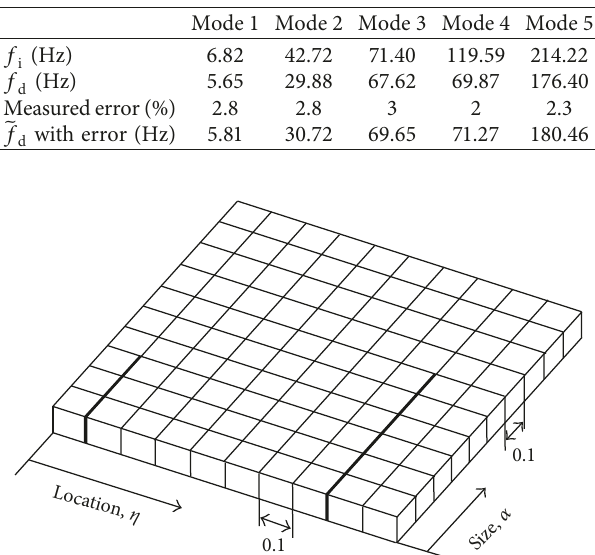
y / L , α a / b ) with actual crack (cid:31) (cid:31)